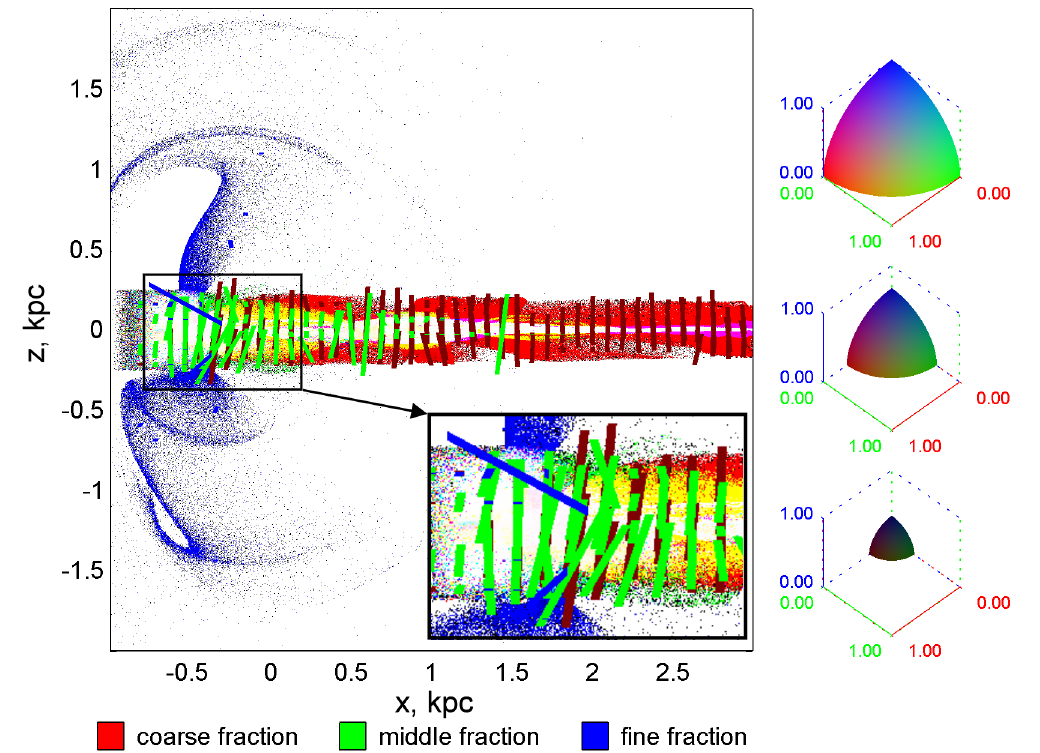
Figure 3. The distribution of eccentricities (scalar color field) and tensor field of the main directions of dispersion ellipses for a mixture of three particle fractions. The segments represent the part of the tensor field corresponding to those principal directions along which the dispersion is